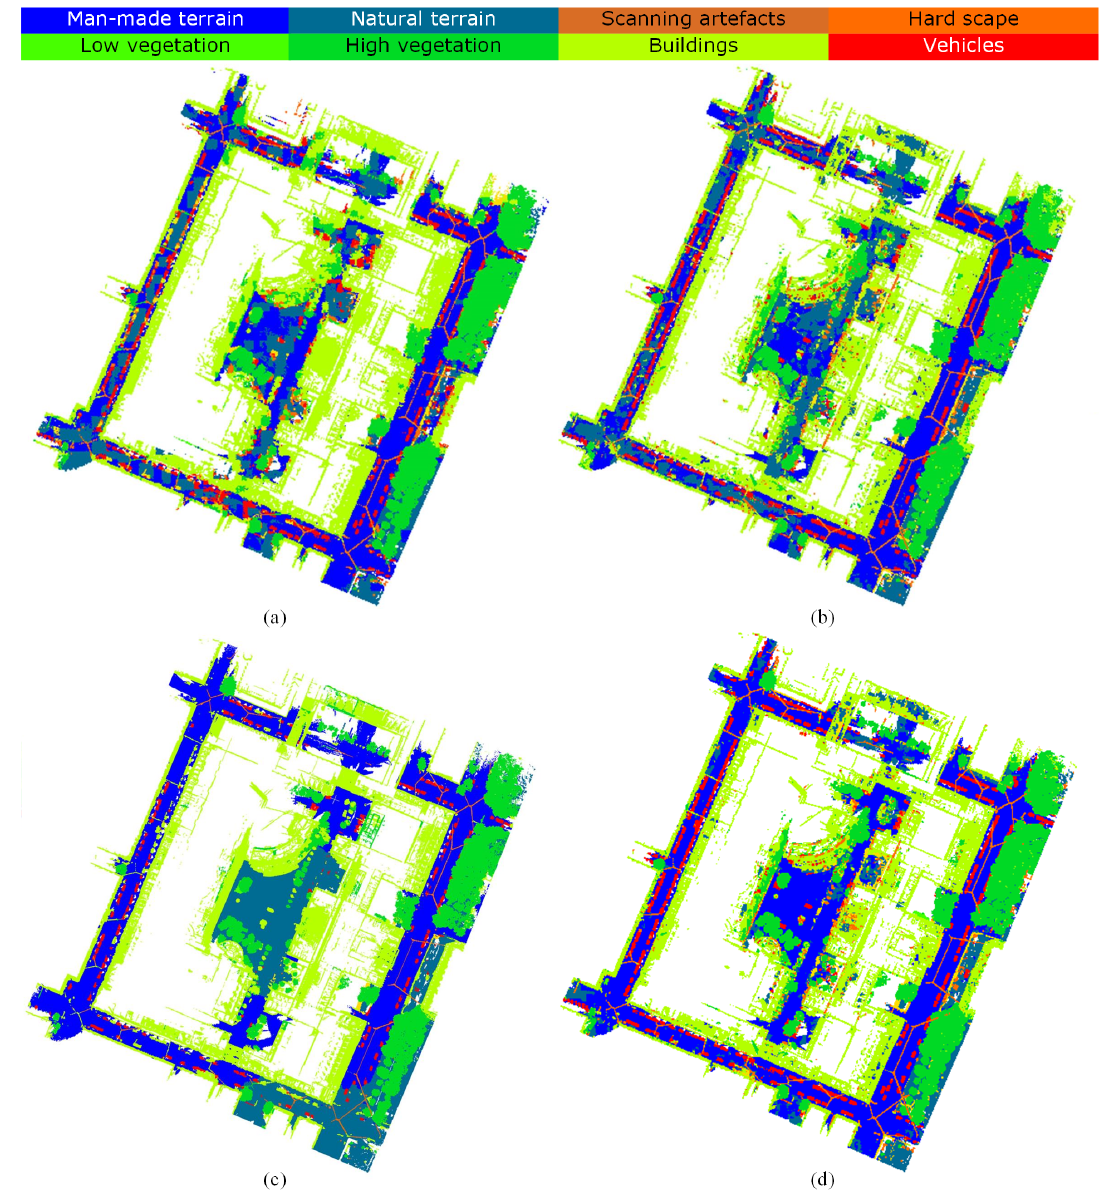
Figure 12. Comparison of classification results using different methods. ( a ) Classification result using PointNet [23], ( b ) classification result using PointNet++ [24], ( c ) classification result using DEGO [25], and ( d ) classification result using HDL